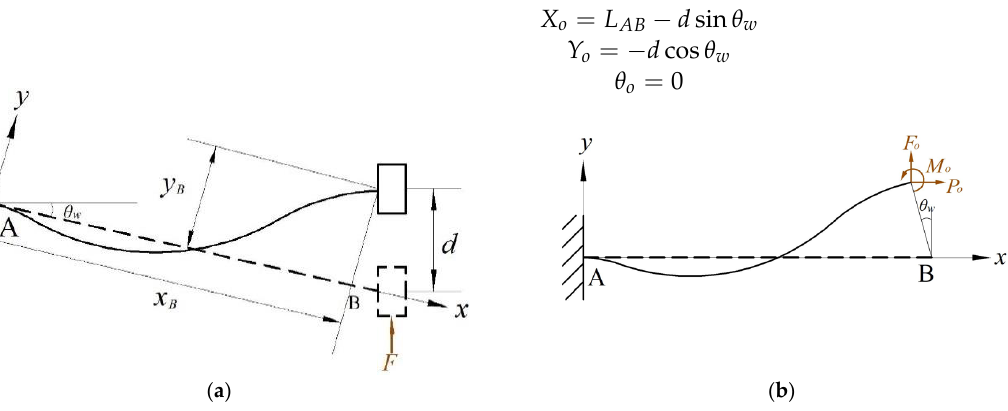
Figure 7. Schematic of the bi-stable beam: ( a ) schematic of the bi-stable beam; ( b ) force of the positive coordinate system.